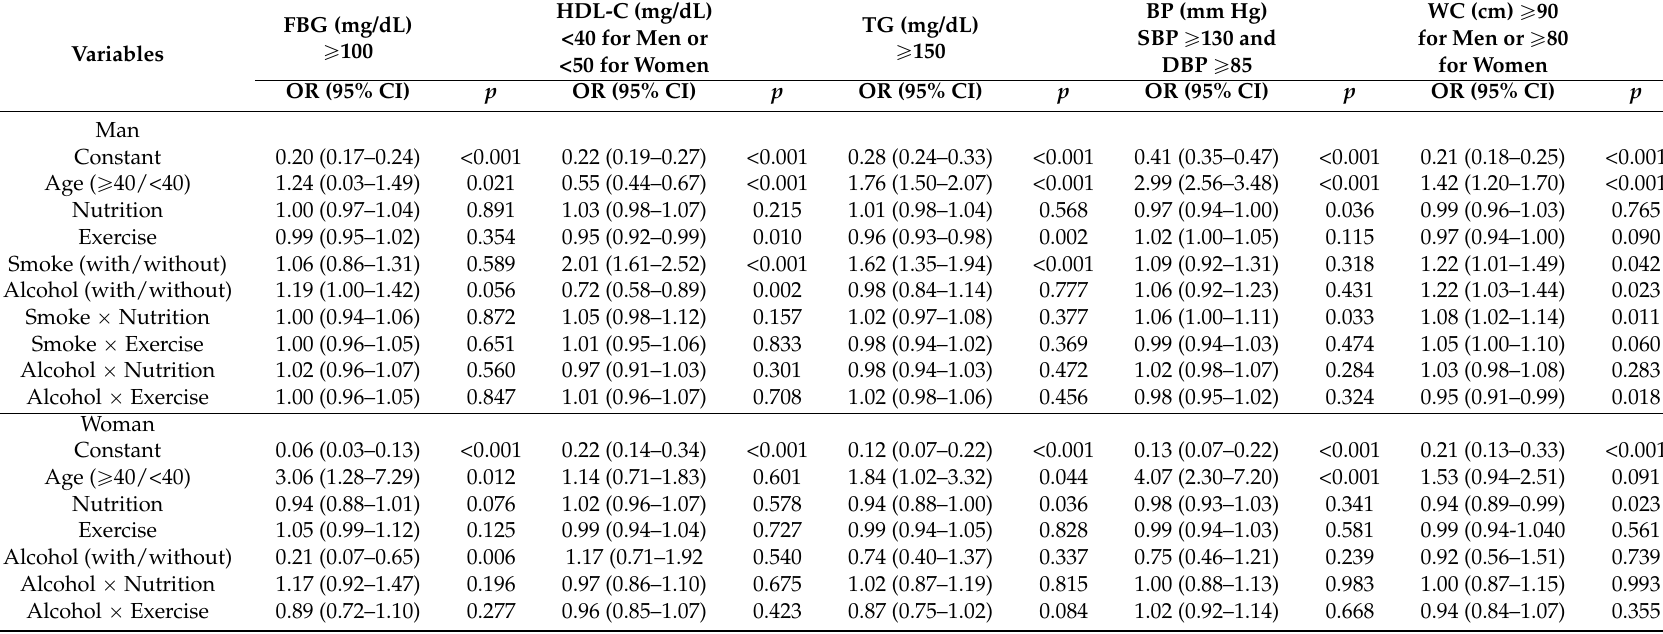
Table 3. Interactions between smoking/alcohol habits and exercise/nutrition behaviors on the risk of metabolic